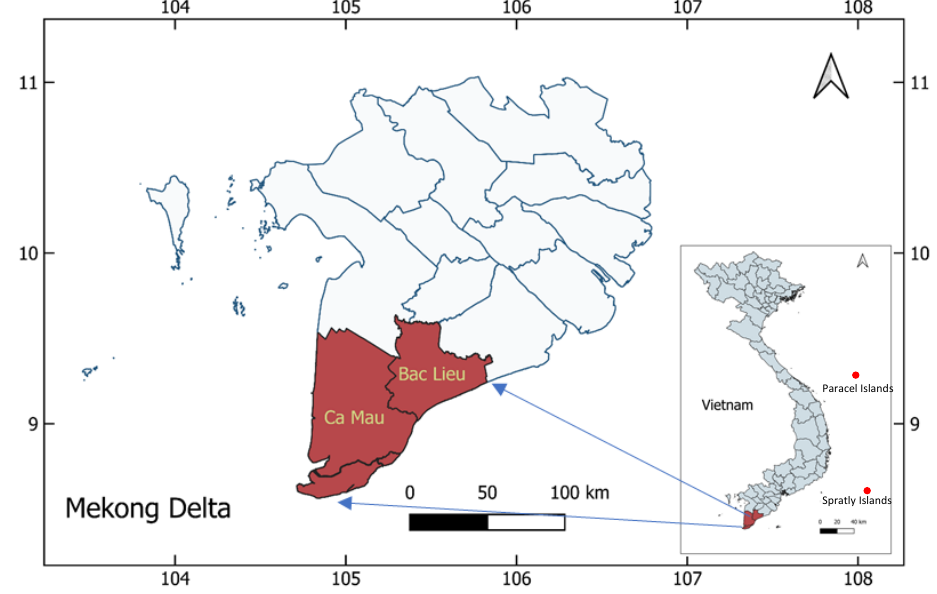
Figure 1. Study area in Bac Lieu and Ca Mau provinces, Vietnamese Mekong Delta.